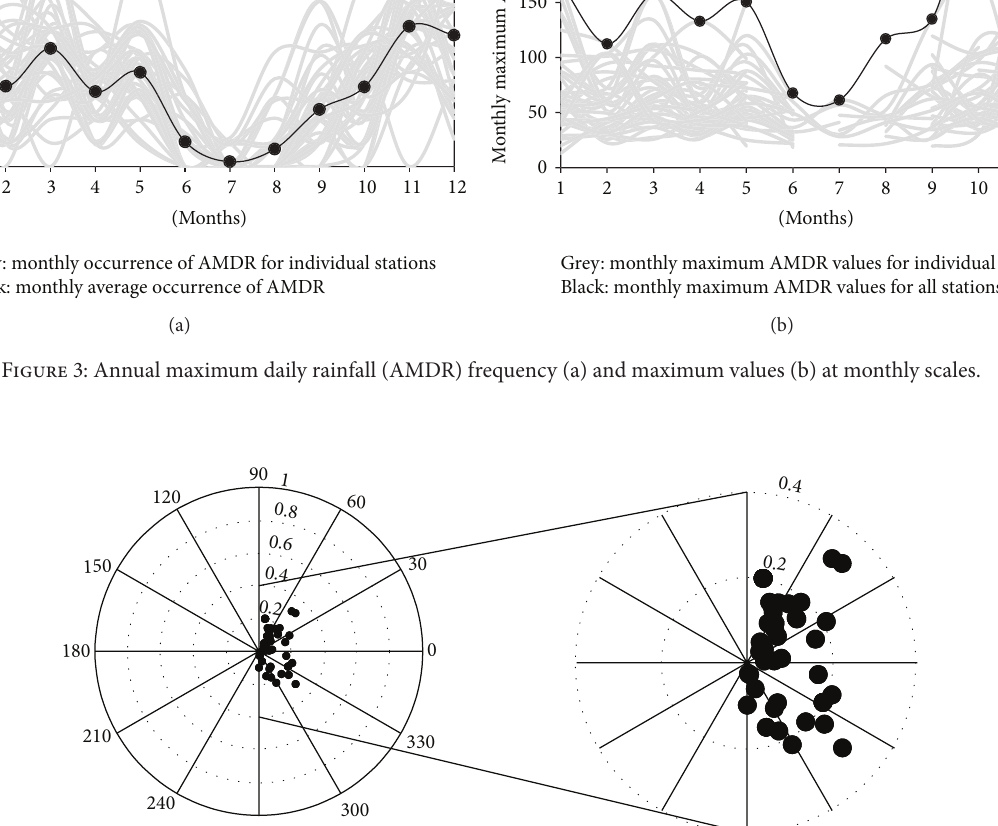
Figure 4: Location of seasonal concentration index 𝑟 for AMDR. The angles: 0 ∘ represents January 1; 90 ∘ represents April 1; 180 ∘ represents July 1; and 270 ∘ represents October